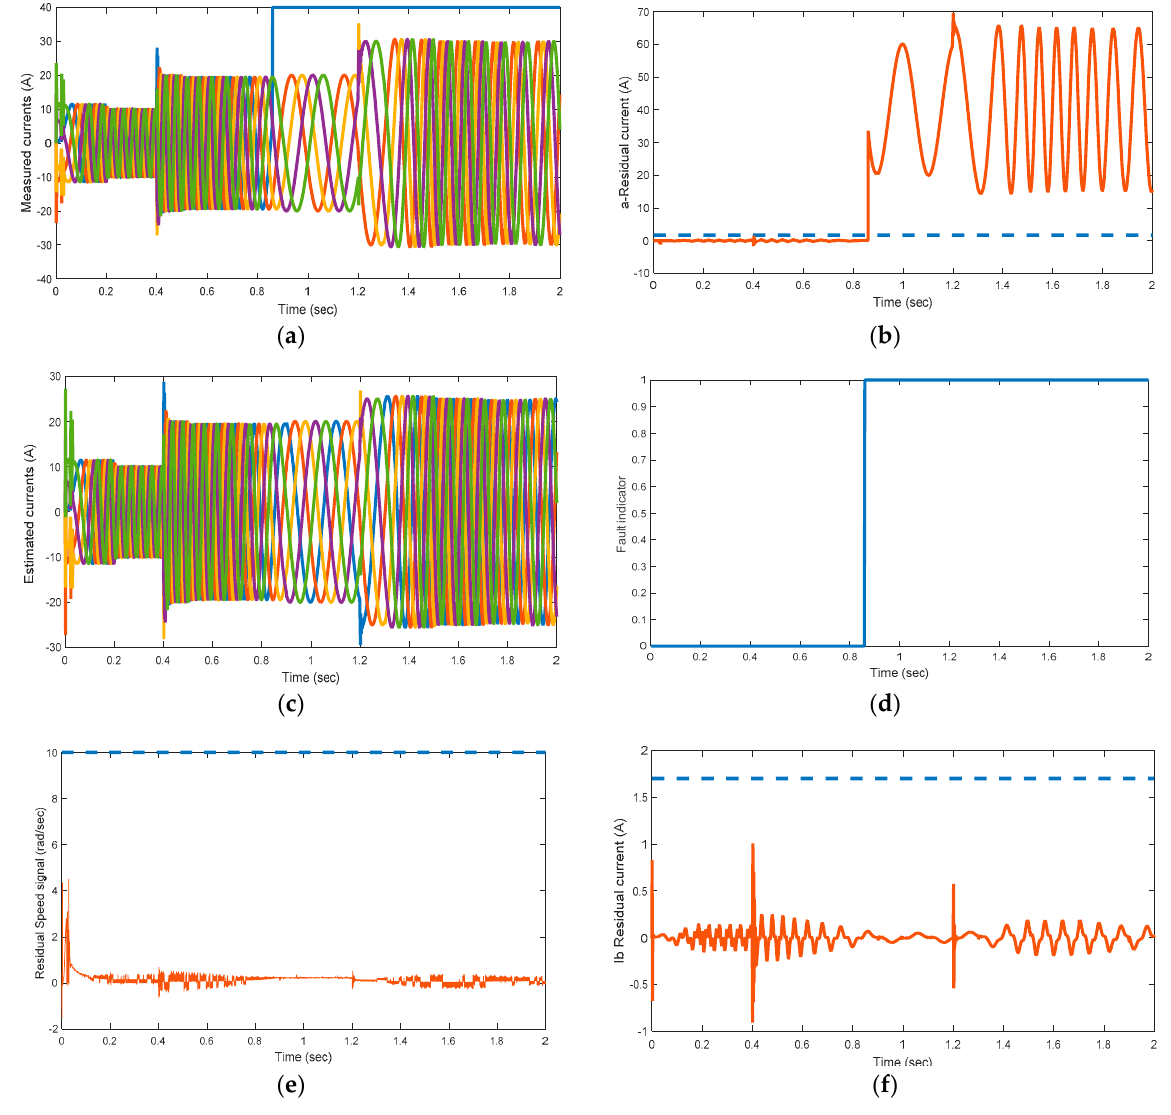
Figure 5. 5P-PMSM performance with constant fault applied in phase “a”. ( a ) Stator currents with a-phase fault application; ( b ) residual of a-phase current; ( c ) estimated stator currents; ( d ) fault indicator; ( e ) residual rotor speed; ( f ) residual b-phase current.